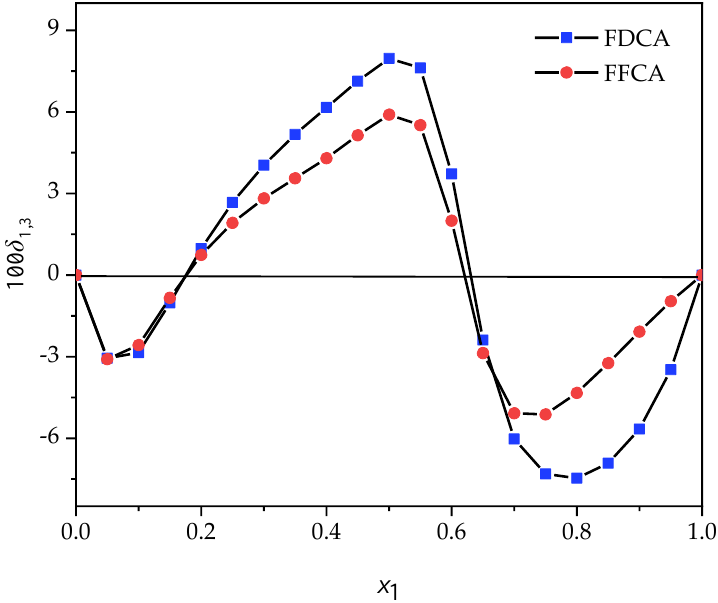
Figure 4. Preferential solvation parameter ( δ 1,3 ) values of FDCA and FFCA in binary water + 1,4- dioxane with different solvent mixing ratios at 303.15 K.